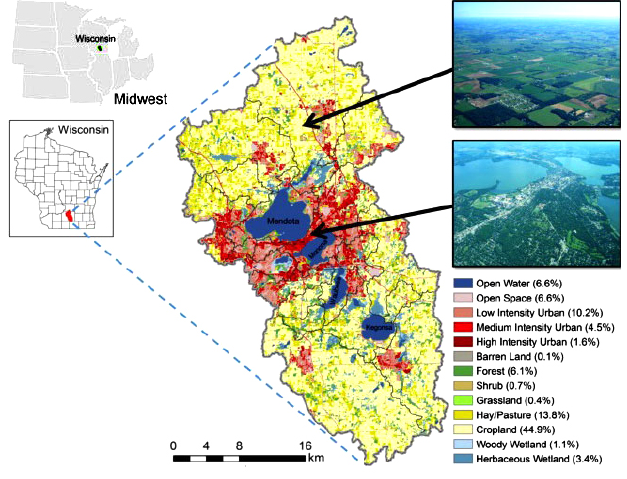
Fig. 1 . Map of the Yahara River watershed (Wisconsin, USA) and the land use/land-cover pattern (with percent cover) for 2011, derived from National Land Cover Data. Delineations of the Yahara watershed were based on light detection and ranging (LiDAR) elevation, sewer-sheds from the city of Madison, and a field-checked basin map from Dane County, Wisconsin. Two aerial photos in the upper-right corner were taken in summer 2013 and illustrate the typical agricultural landscape (top) and acceleration of urbanization (bottom) in this watershed. Reprinted from Carpenter et al. 2015 a